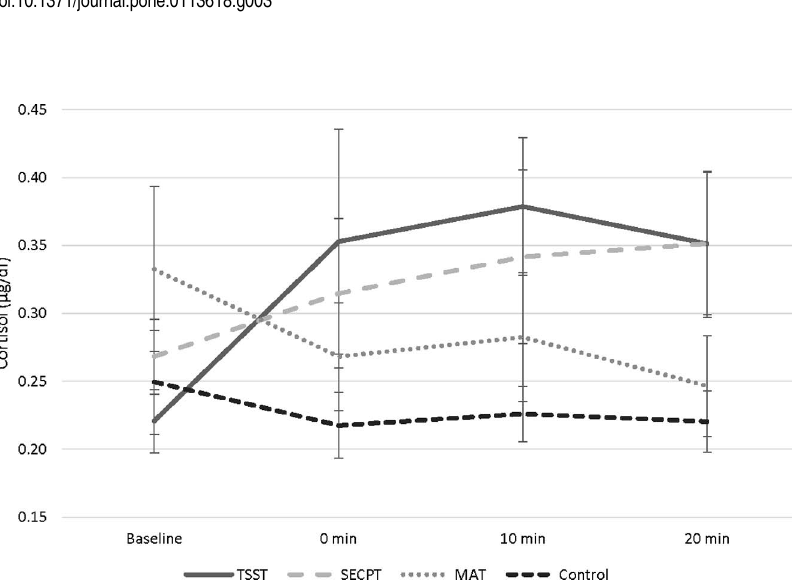
Fig. 4. Salivary cortisol concentration. Salivary cortisol as a function of stress condition and time (means and standard errors) pre-stress and at 0-, 10-, and 20-minutes post-stress. Although ANOVAs were performed on log-transformed data, the figure shows raw data. Cortisol levels were higher than baseline at all time-points following the TSST ( p , 0.01), but not the SECPT, MATor control task (all p s . .08). Additionally, cortisol levels were higher during the TSST and SECPT conditions 20-minutes post-stress ( p , 0.05) but not during the the MAT or for any stressors pre-stress, or immediately or 10 minutes post-stress (all p s .